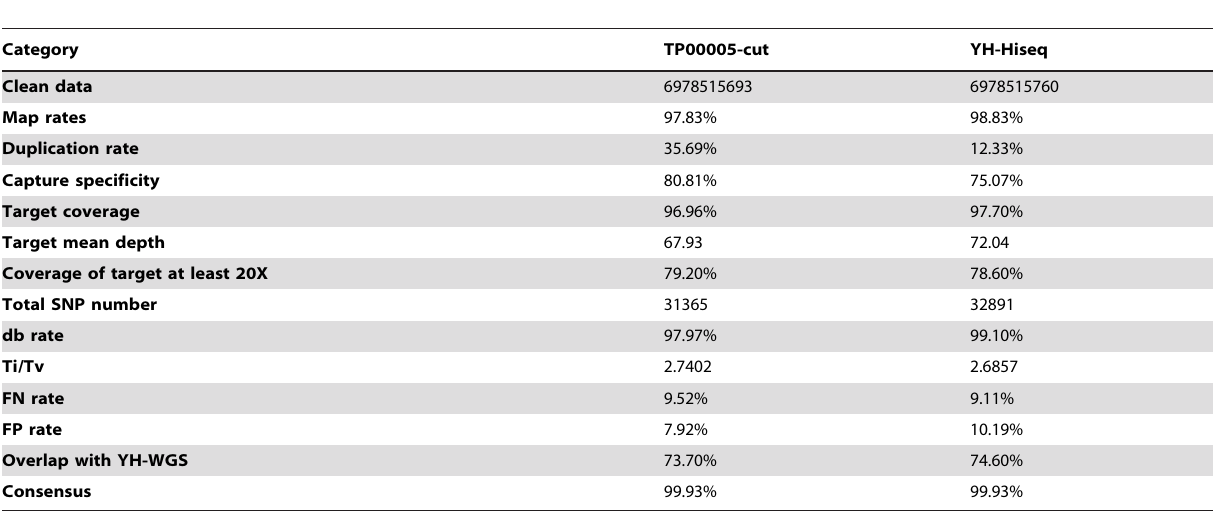
Table 4. Comparison of the OTG-snpcaller and Hiseq